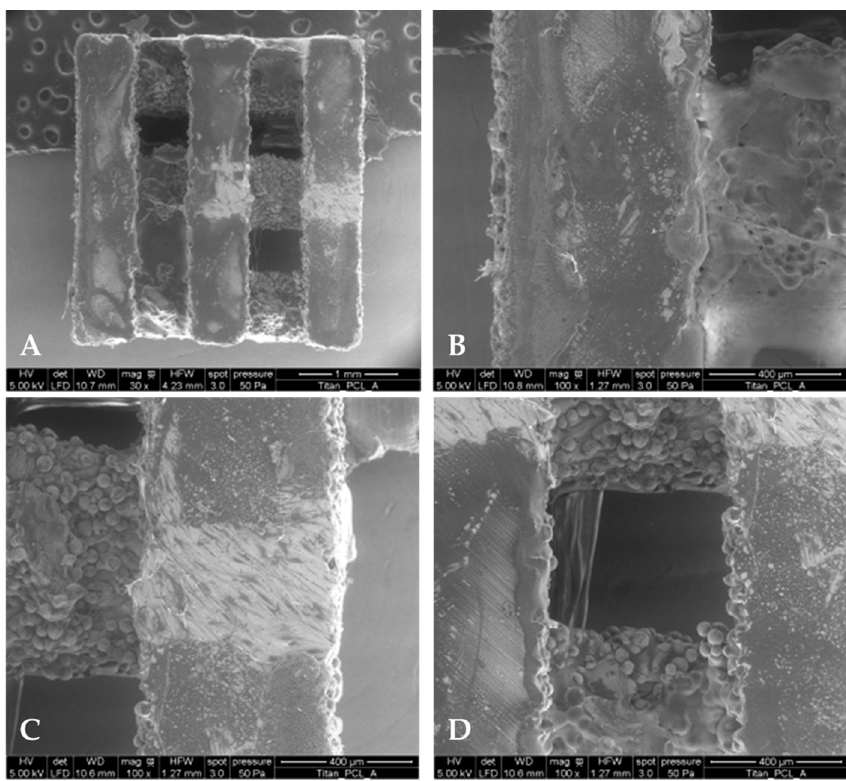
Figure 1. ESEM (environmental scanning electron microscopy) pictures (Quanta FEG 250, FEI, Eindhoven, The Netherlands) of PCL-coated titanium implant. The whole implant ( A ) was imaged as well as different parts of the implant ( B – D ). After fixing the implants, the scanning electron micrographs were performed at 50 Pa pressure, with moisturized atmosphere and an accelerating voltage of 5 kV (HV = high voltage; det = detector; LFD = large field detector; WD = working distance, HFE = horizontal field width, mag = magnification). Table 1. PCL coating thickness of the in vitro tested Titanium Scaffolds ( n = 3).